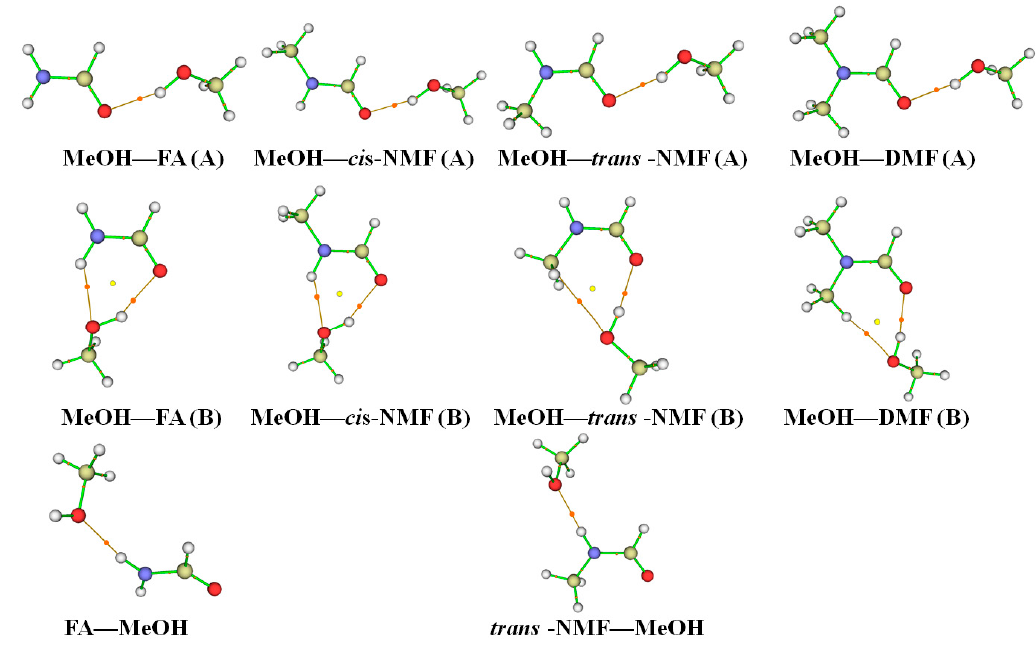
Figure 4. The Atoms in Molecules (AIM) plots of the MeOH–formamide and formamide–MeOH complexes obtained at the B3LYP-D3/aug-cc-pVTZ level; The bond critical points (BCPs) and ring critical points (RCPs) are presented by the ginger and yellow balls, respectively; FA: formamide; NMF: N -methylformamide; DMF: N , N -dimethylformamide; MeOH: methanol.